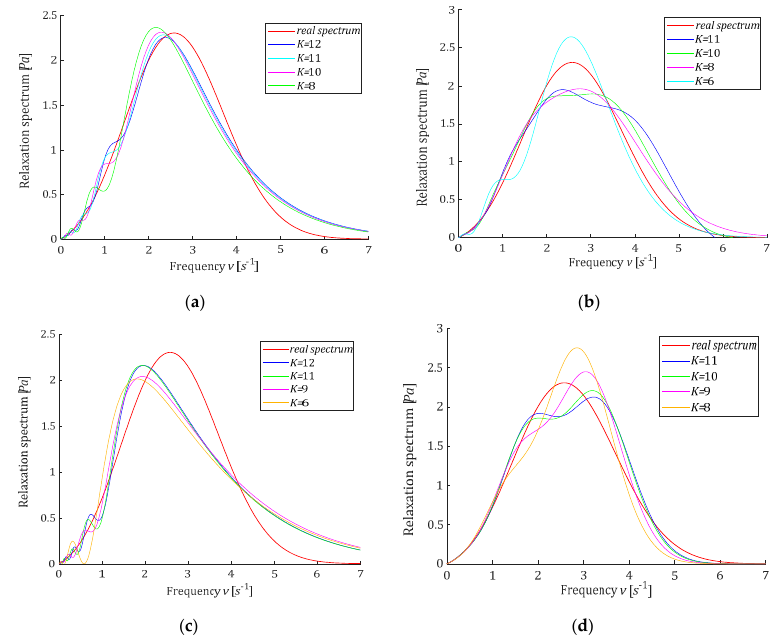
Figure 6. Relaxation spectrum H ( v ) (57) (solid red line) from Example 1 and the approximated models H K ( v ) (23): ( a ) Legendre, ( b ) Laguerre, ( c ) Chebyshev, ( d ) Hermite.